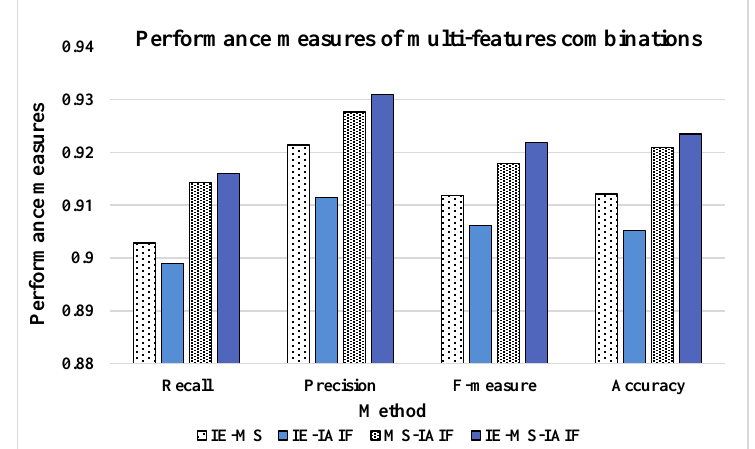
Figure 12. Performance measures of multi-features